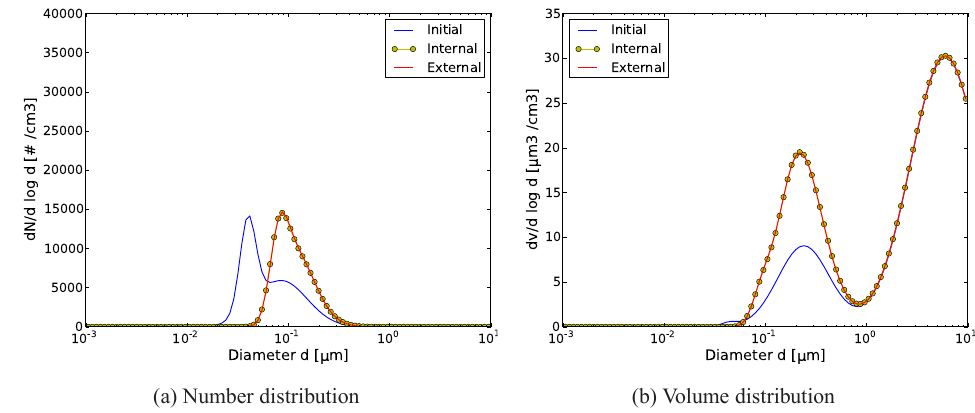
Figure 3. Simulation of both coagulation and condensation for hazy conditions: initial distribution and after 12h.